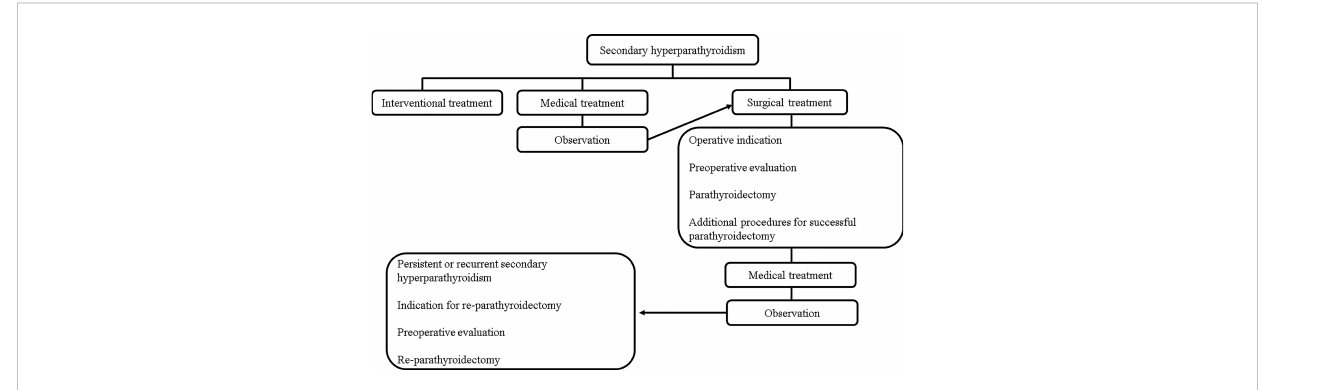
FIGURE 1 Flowchart of secondary hyperparathyroidism